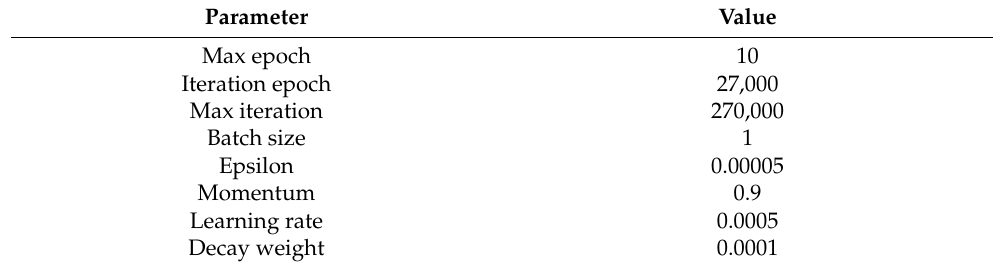
Table 3. Model training parameters.